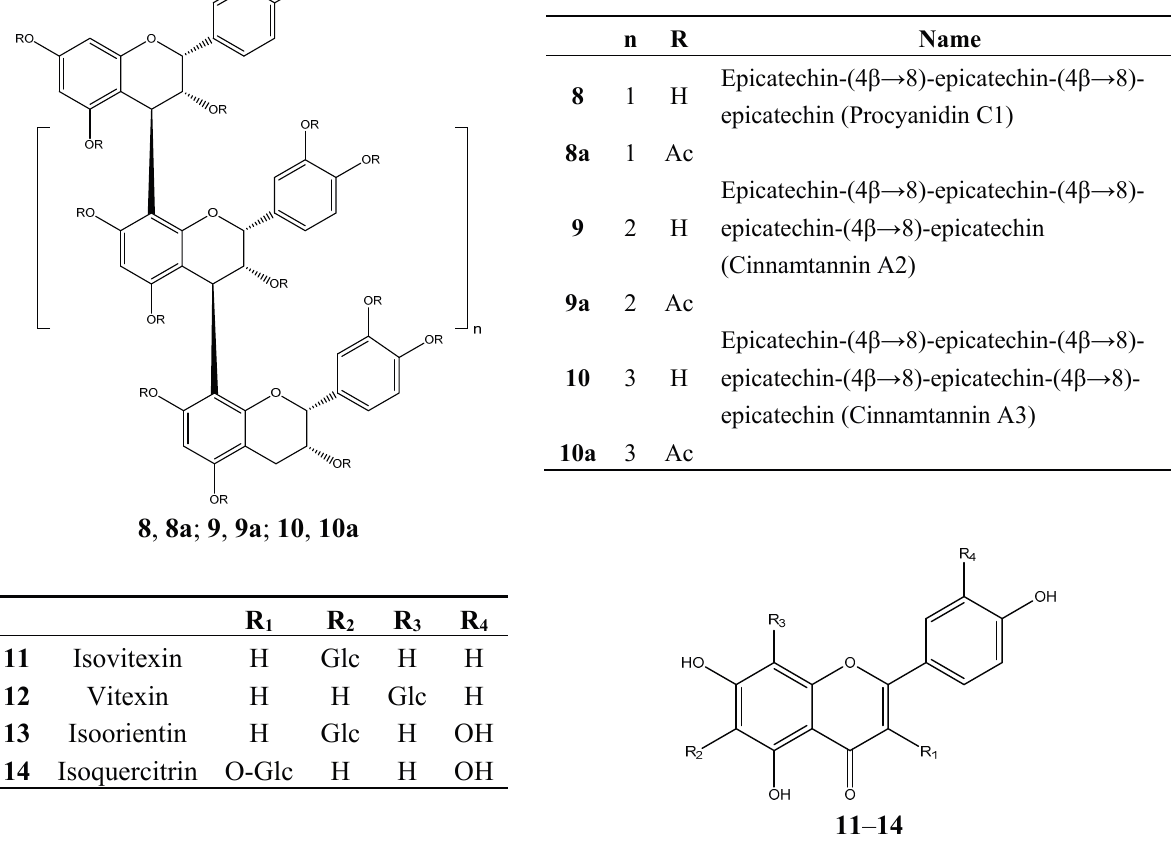
Figure 2. Structural features of the oligomeric proanthocyanidins, proanthocyanidin peracteates and flavonoids isolated from C. mucronatum ; peracetylated OPCs were used for unambiguous structure